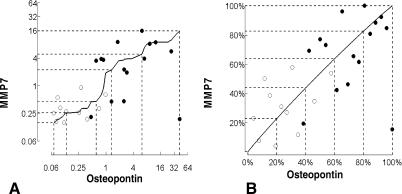
Weakest Link Models of Osteopontin and MMP-7IPF samples are depicted in solid dots and controls in open dots; the y-axis is MMP-7 expression and x-axis is osteopontin expression. Black solid line is the curve of optimal use showing that the expression levels for MMP-7 and osteopontin jointly interact to determine the IPF phenotype. The probability contour plot is shown in terms of the observed expression data (scale is log base 2 for gene expression data) (A); and probability contour plot is shown in terms of percentiles of the data (scale is percentiles) (B).